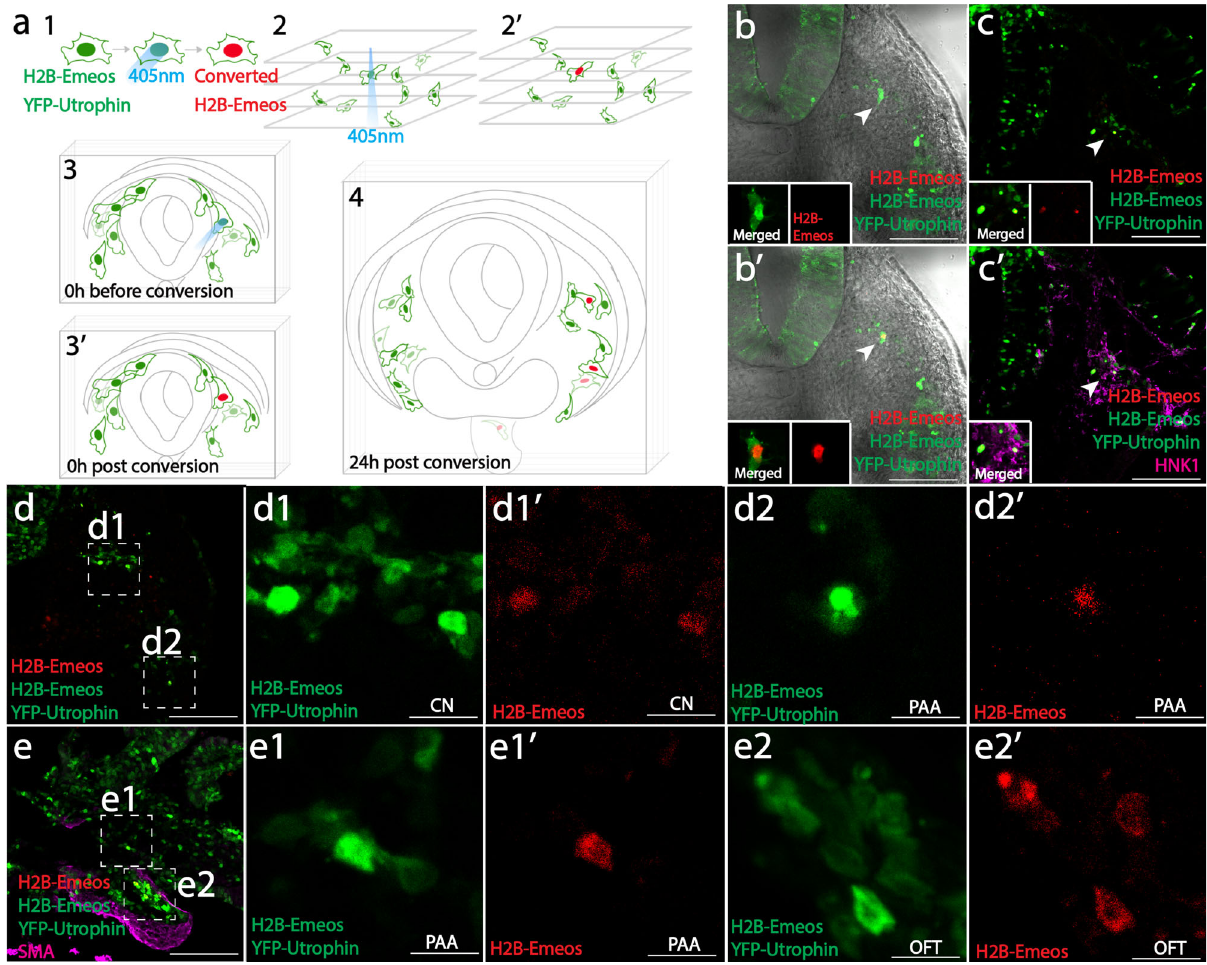
Fig. 2 Single-cell photoconversion identi fi es multipotency of migratory cardiac neural crest cells. a Implementing the single-cell photoconversion technique in embryo slices. In (1), cells were labeled with virus expressing both YFP-Utrophin and H2B-Emeos. A single migratory neural crest cell was converted (2, 2 ′ , 3, 3 ′ ), and the tissue slice was cultured for 24 h until its progeny migrated to their destinations (4). Clones are assessed based on red fl uorescence in the nucleus and green fl uorescence underneath the plasma membrane. b , c A representative experiment of single-cell photoconversion and lineage tracing. One migratory cell was photoconverted (b, b ′ ); after 24 h, two daughter cells were observed in the migration stream (c), where cranial nerve is expected to form. Both cells were positive for neural crest marker HNK1 (c ’ , magenta). d An example of a clone with two cells in the cranial nerve (inset d1, CN), and the other cell in prospective pharyngeal arch arteries (Inset d2, PAA). e An example of a clone with one cell located in pharyngeal arch arteries (Inset e1, PAA), and three cells migrating further into the out fl ow tract (Inset e2, OFT). Also see Supplementary Fig. 1e, f for signal detection method and summary of the results (Supplementary Fig. 1g). Scale bars: b – e 200 μ m; Insets d1, d2, e1, e2 12.5 (Fig. 3k). For clonal analysis, four sites including the dorsal neural